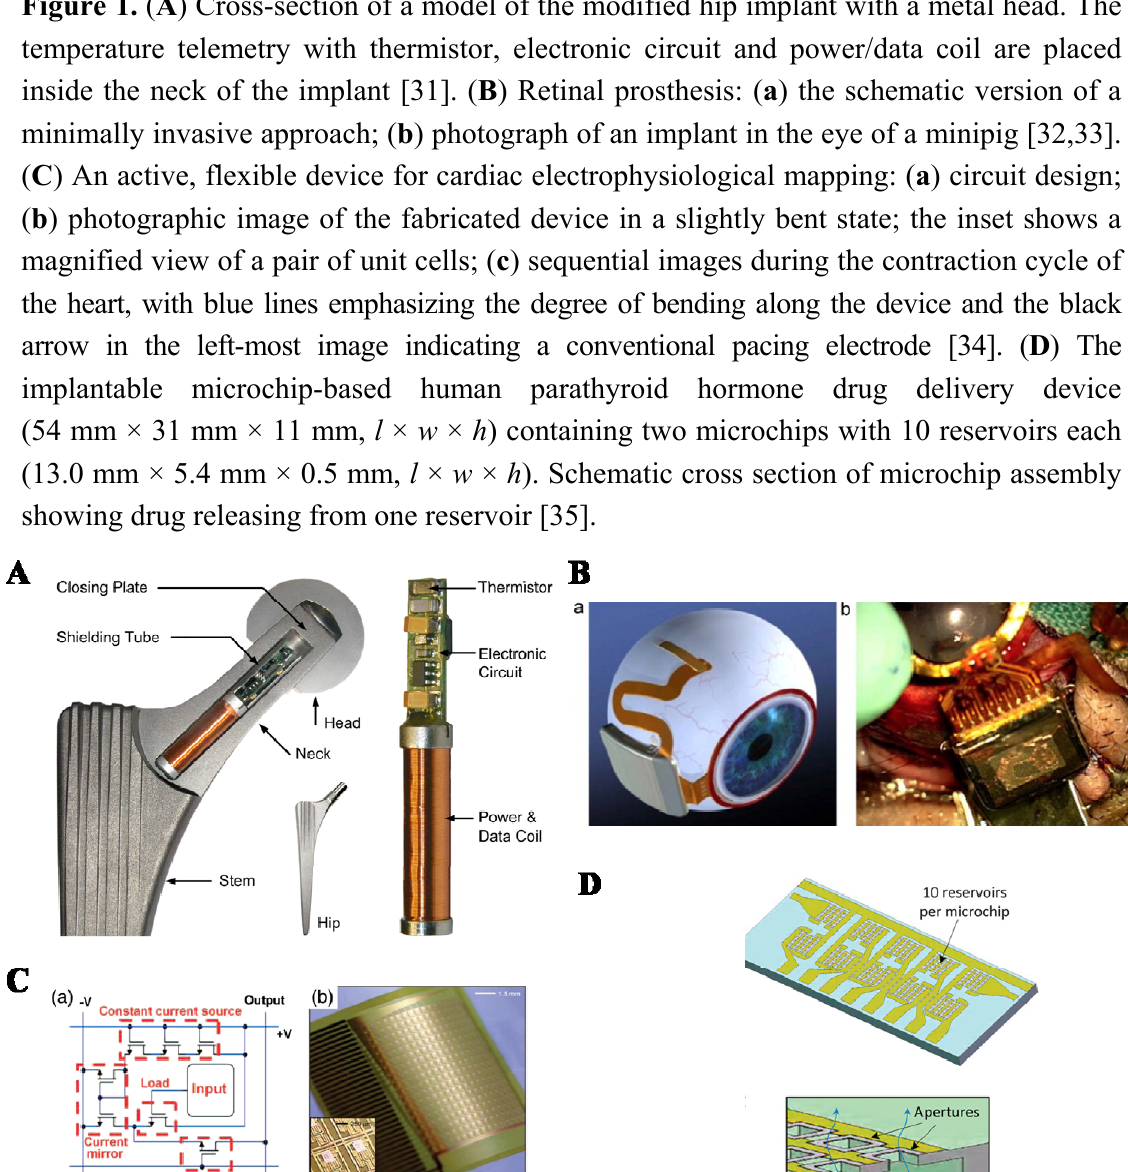
Figure 1. ( A ) Cross-section of a model of the modified hip implant with a metal head. The inside the neck of the implant [31]. ( B ) Retinal prosthesis: ( a ) the schematic version of a